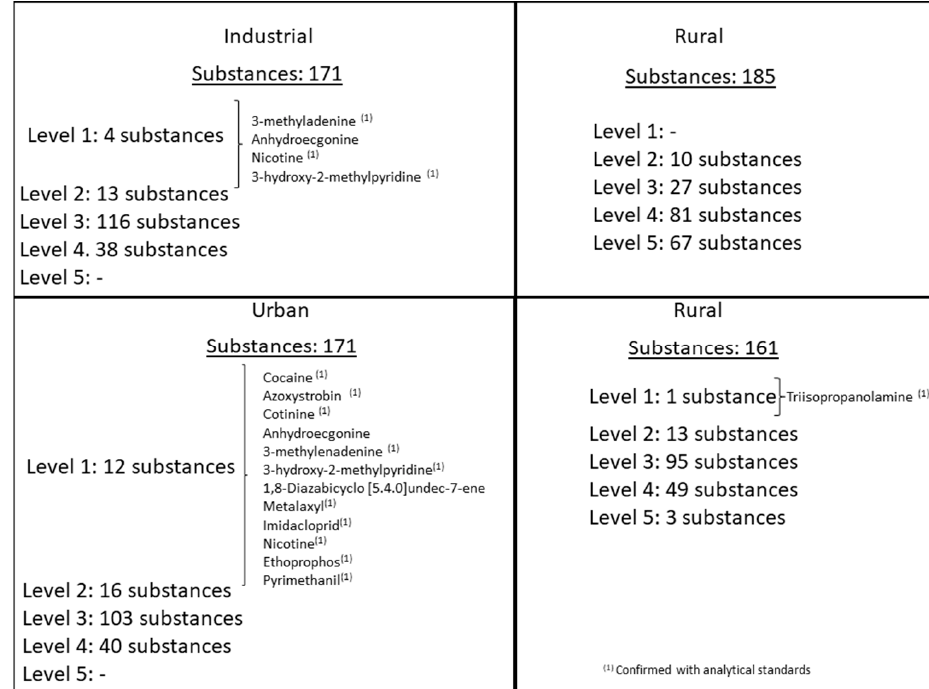
Figure 3. Obtained results in the Volcano plots (industrial vs. rural and urban vs. rural).